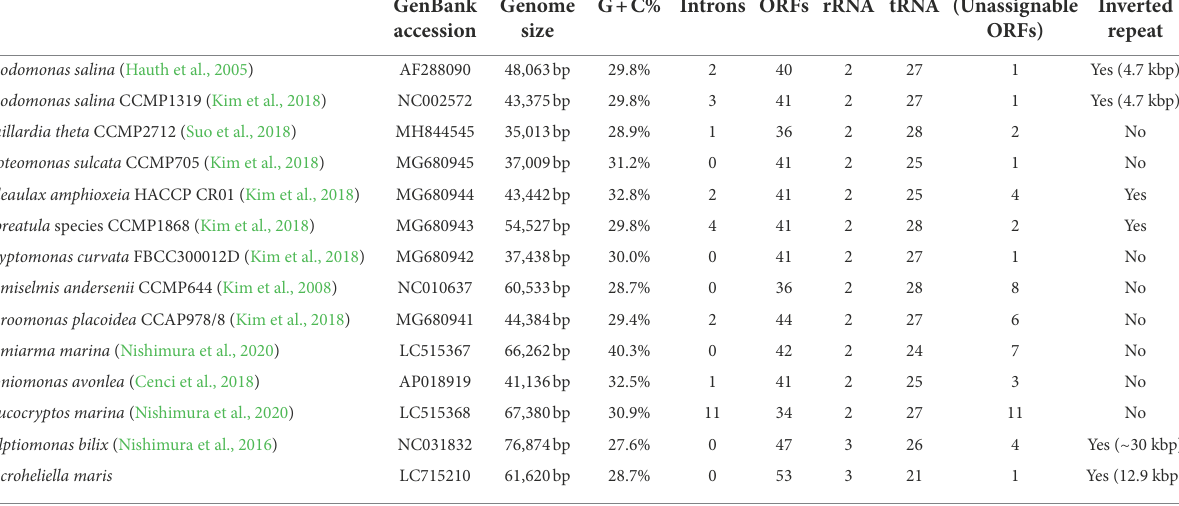
TABLE 1 Characteristics of the Pancryptista mitochondrial